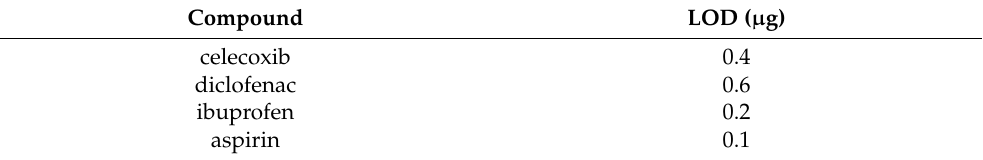
5 of 10 Figure 1. COX-2 TLC assay with 50 µg of some standard compounds: ( a ) eugenol, ( b ) salicylic acid, ( c ) celecoxib, ( d ) ibuprofen, ( e ) acetylsalicylic acid, ( f ) diclofenac. 3.3. Limits of Detection and Linearity Once all parameters were set, the sensitivity of the TLC assay was estimated for the COX inhibitors celecoxib, ibuprofen, diclofenac, and aspirin, by assessing the visual limit of detection for each compound. The LOD values were comprised between 0.1 µg and 0.6